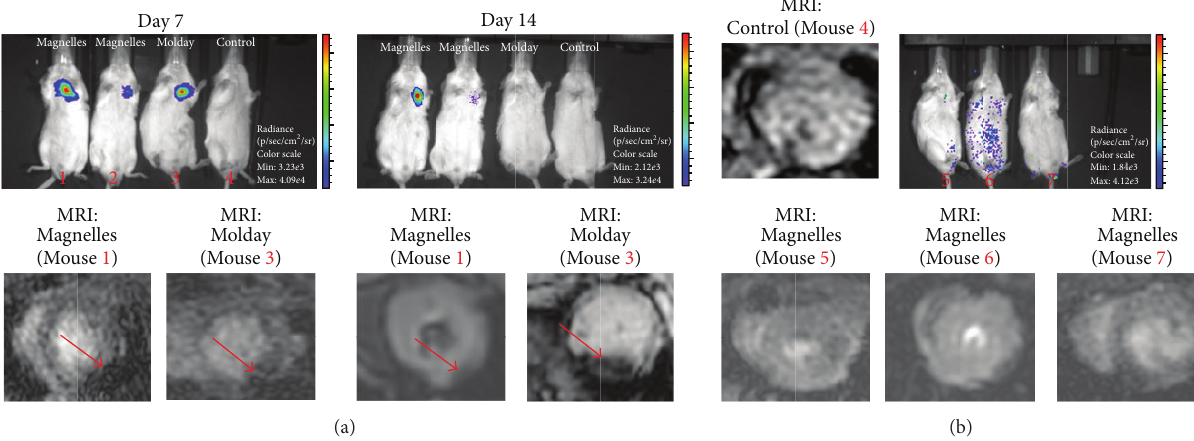
Magnelles Magnelles Molday Control